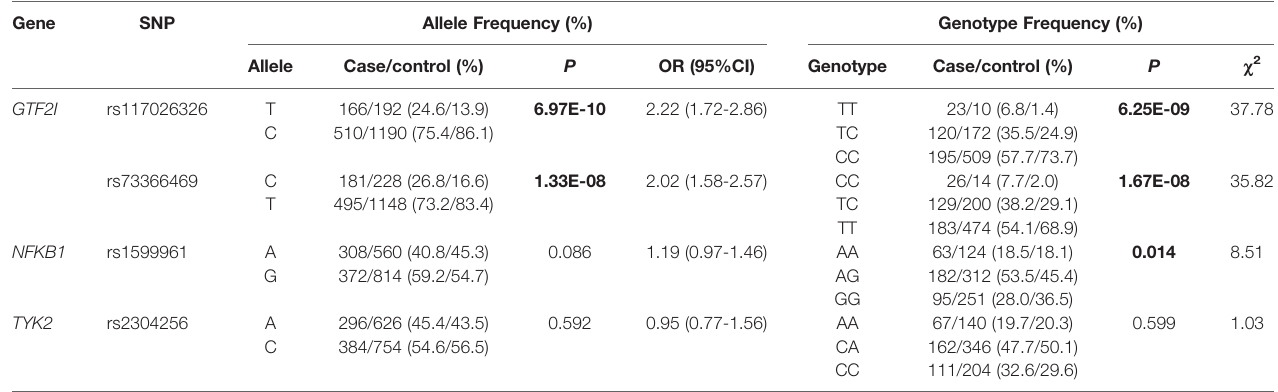
TABLE 3 | Allele and genotype frequencies in patients with SSc and controls.